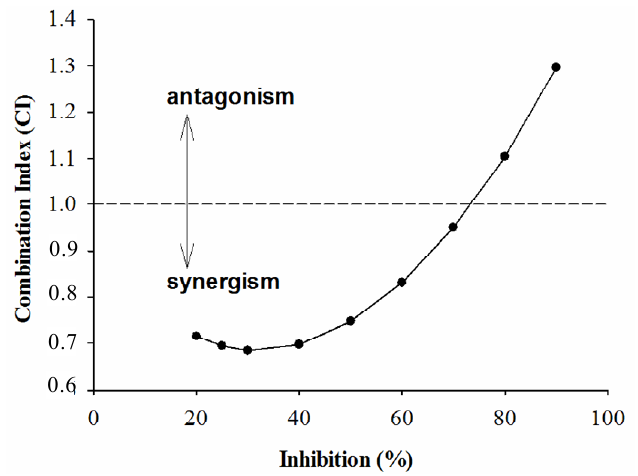
Figure 4. The CI of interaction between GTE and acarbose of inhibition on α -amylase.